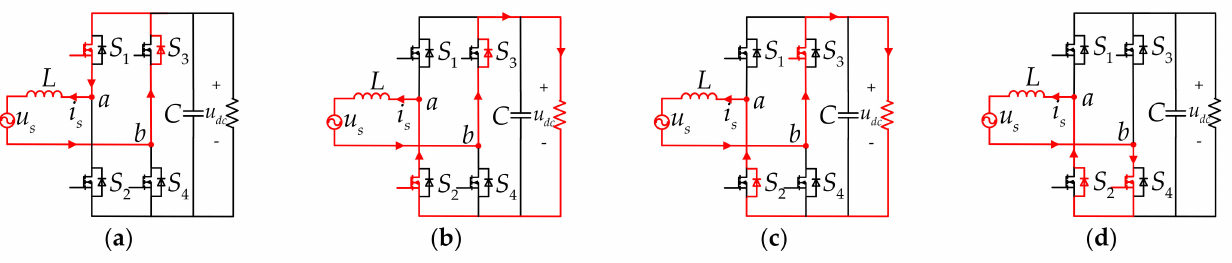
Figure 8. The current path during the dead-time when i s < 0. ( a ) (1,0,0,0); ( b ) (0,1,0,0); ( c ) (0,0,1,0); ( d ) (0,0,0,1).